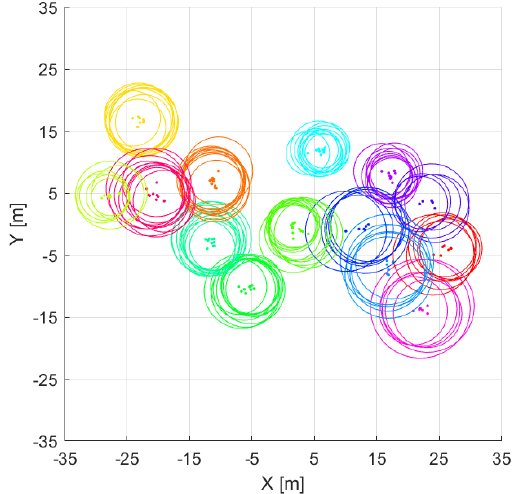
Figure 10 shows visually the significant increase of the quality measures after the data integration for both datasets. Figure 11 shows the input data, the reference data and the result of the integration on one example data section of the V3D dataset.